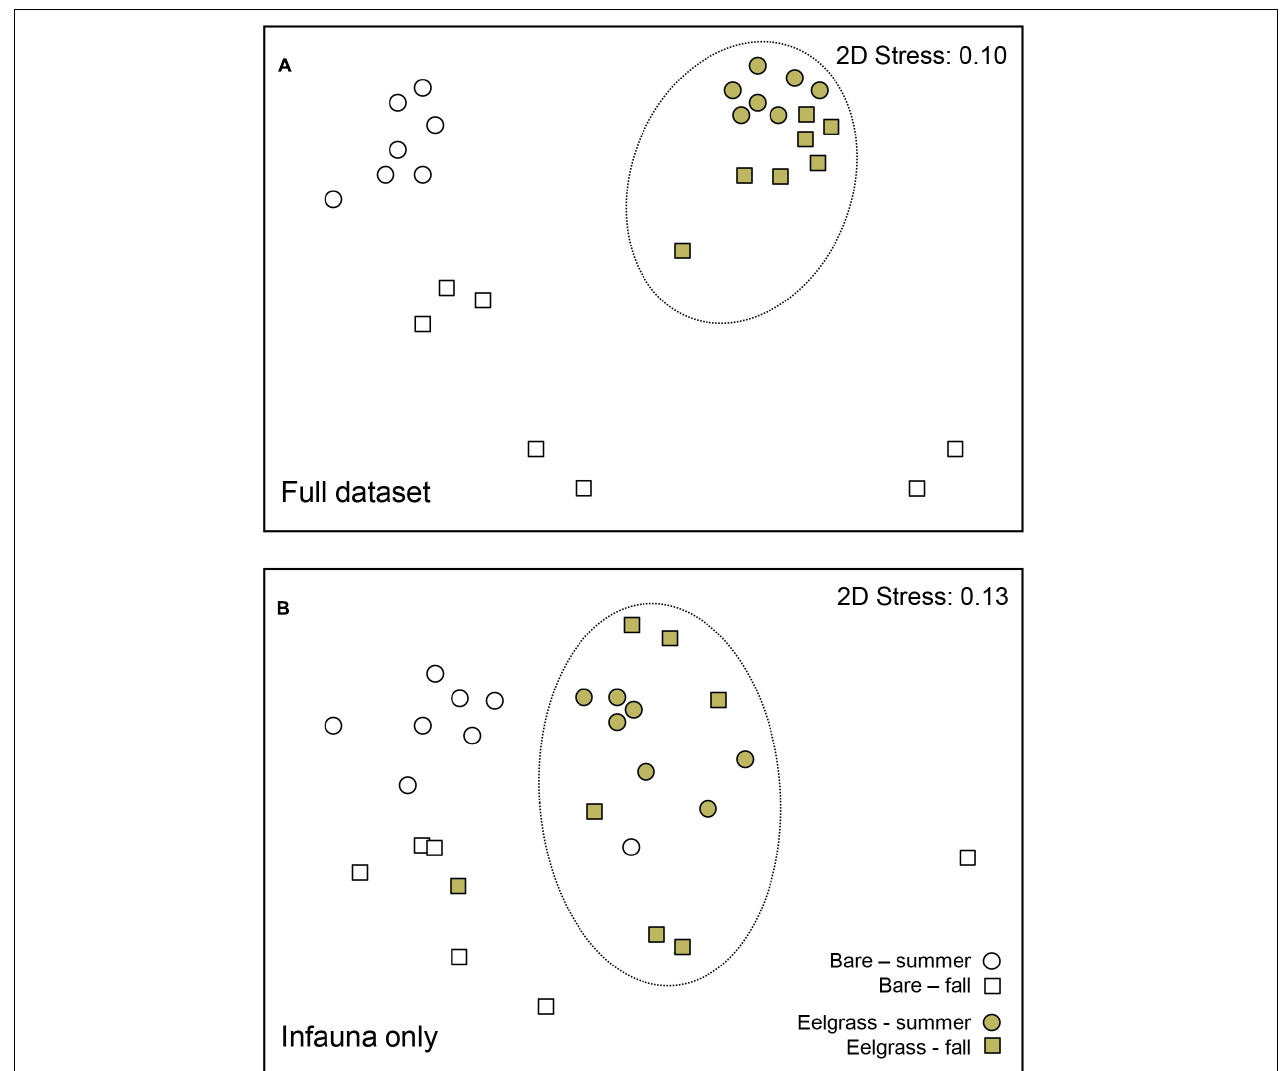
FIGURE 3 | MDS plots illustrating community similarity among samples collected in eelgrass and bare sediment habitats for the 2010 summer and fall surveys combined. Separate plots are presented for the full dataset (A) and for a subset including infaunal species only (B) . Dotted lines encircle primarily eelgrass samples to denote that they are significantly different from bare sediments according to ANOSIM (R-Global = 0.677 and 0.480 for (A,B) , respectively) ( p = 0.001 in both